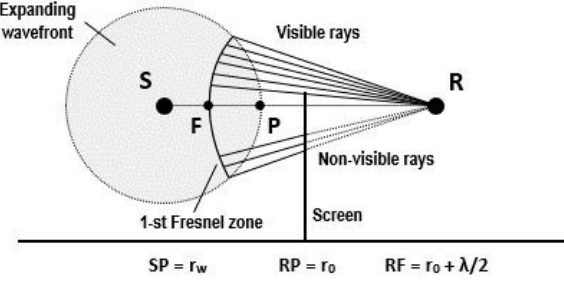
Figure 2: Geometry for the calculation of the diffracted sound pres- sure at time t